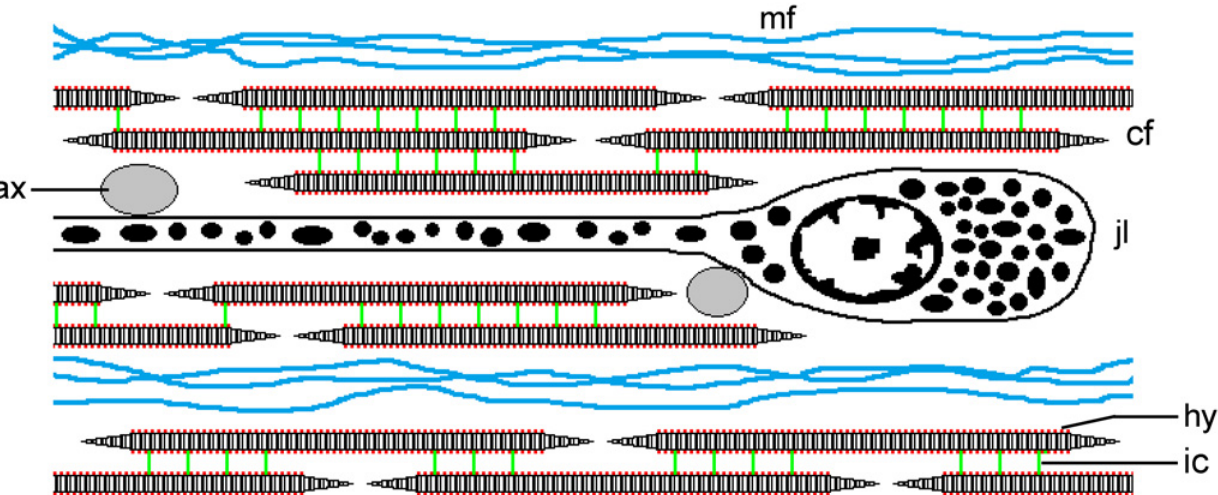
Fig 7. Diagrammatic representation of the CD of P . lividus . This depicts part of a longitudinal section; not to scale. The CD consists of parallel discontinuous collagen fibrils (cf), which are connected by interfibrillar crossbridges containing chondroitin sulphate/dermatan sulphate proteoglycans (ic). Hyaluronic acid (hy) is present but of unknown function (its disposition on the surface of the collagen fibrils is conjectural). Bundles of beaded microfibrils (mf) occur between the collagen fibrils. The main cellular components are the somata and processes of electron-dense granule-containing juxtaligamental cells (jlc). Agranular cell processes, which may be cholinergic axons, are in close contact with the juxtaligamental cells and are shown as transverse sections